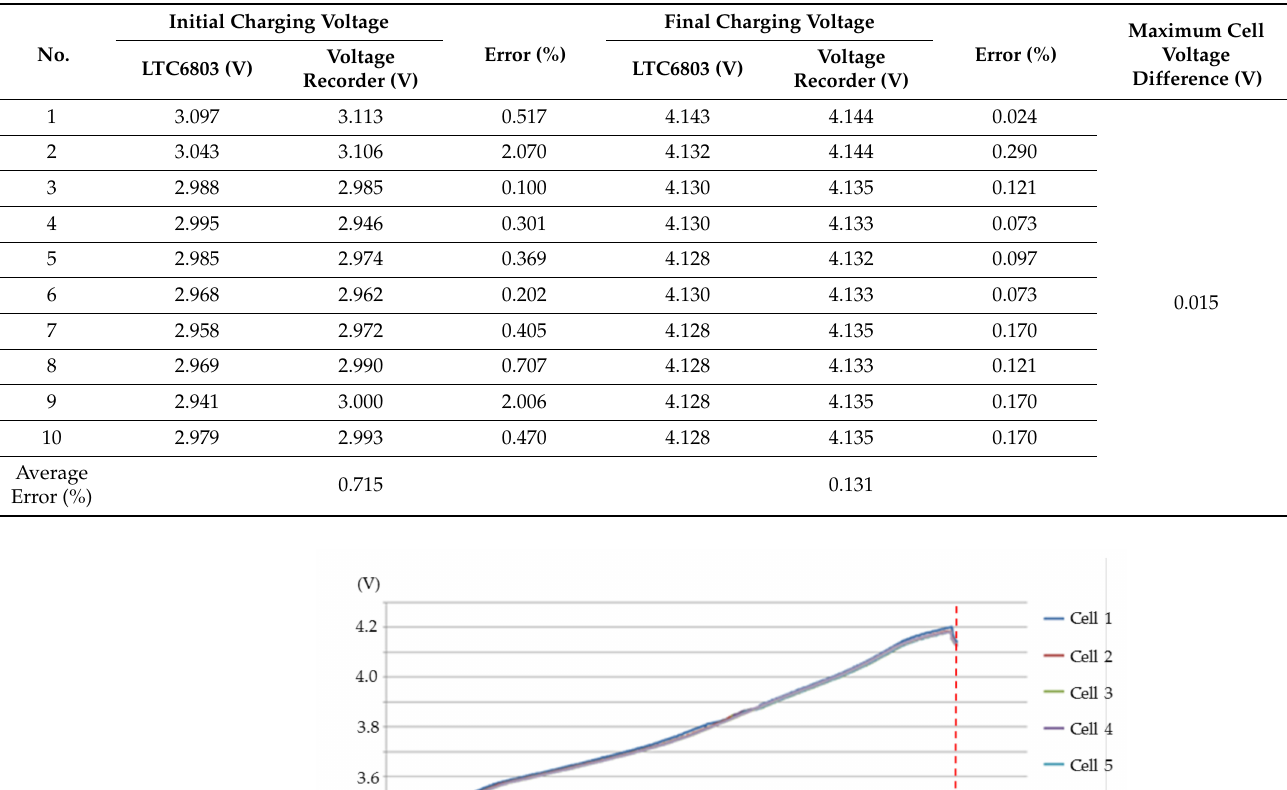
Table 2. Error comparisons of voltage measurement.